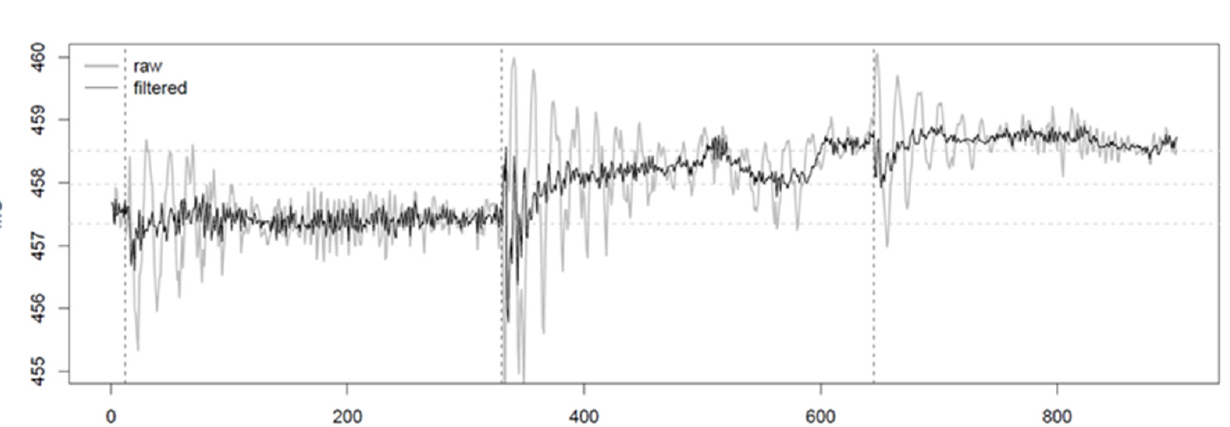
Figure 5. Example of filtering of the magnetic signal by means of the stop-band filters on a portion of 900 samples (3 min) which includes three adjacent magnetic sections. The vertical lines indicate the turn-round positions, immediately before the maximum amplitude of the 0.28 Hz oscillations. The horizontal lines (mean value for each section) highlight a horizontal (southwards) gradient of about 0.6 mG between two consecutive sections.